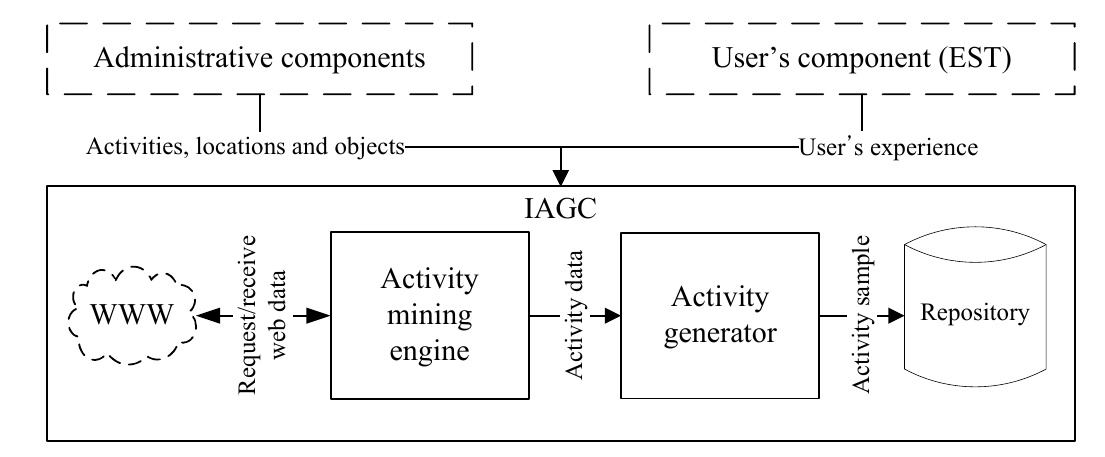
Figure 6. Intelligent Activity Generation